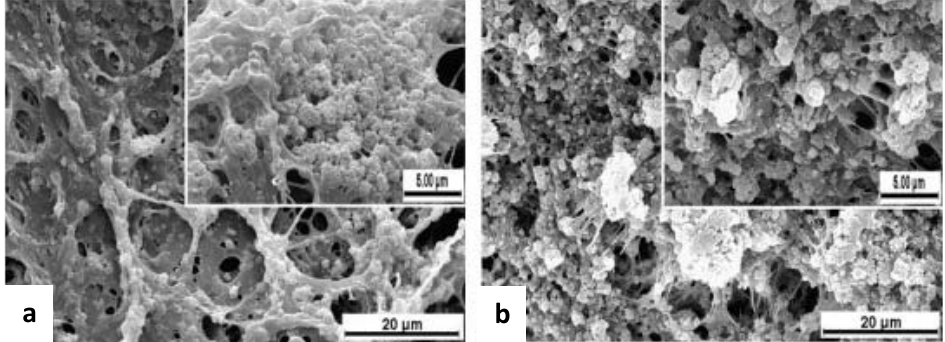
Figure 16. SEM images of hydrogels with different BG contents after being immersed in SBF for 14 days: ( a ) BG-40% and ( b ) BG-50%. Apatite has blossomed on the scaffold in the form of budding spheres. Reproduced from [32] with permission from